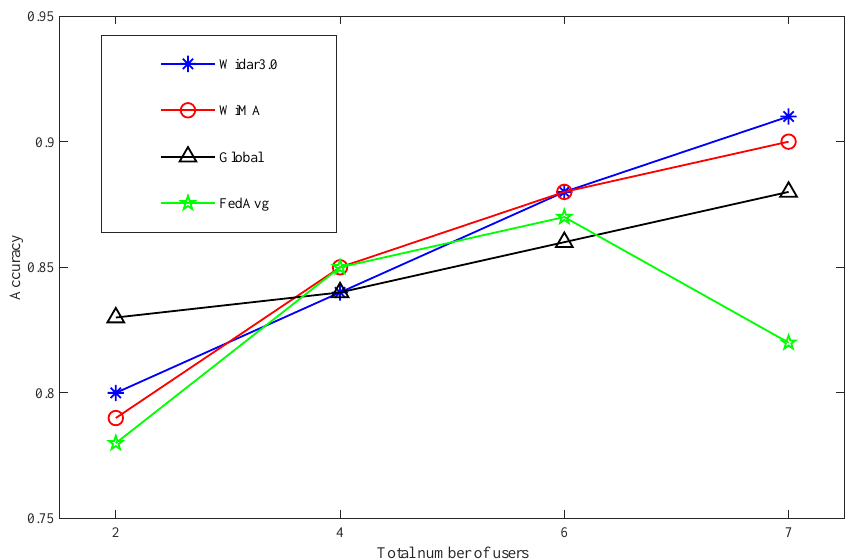
Figure 7. Comparison of WiMA algorithm with three methods—Room1.